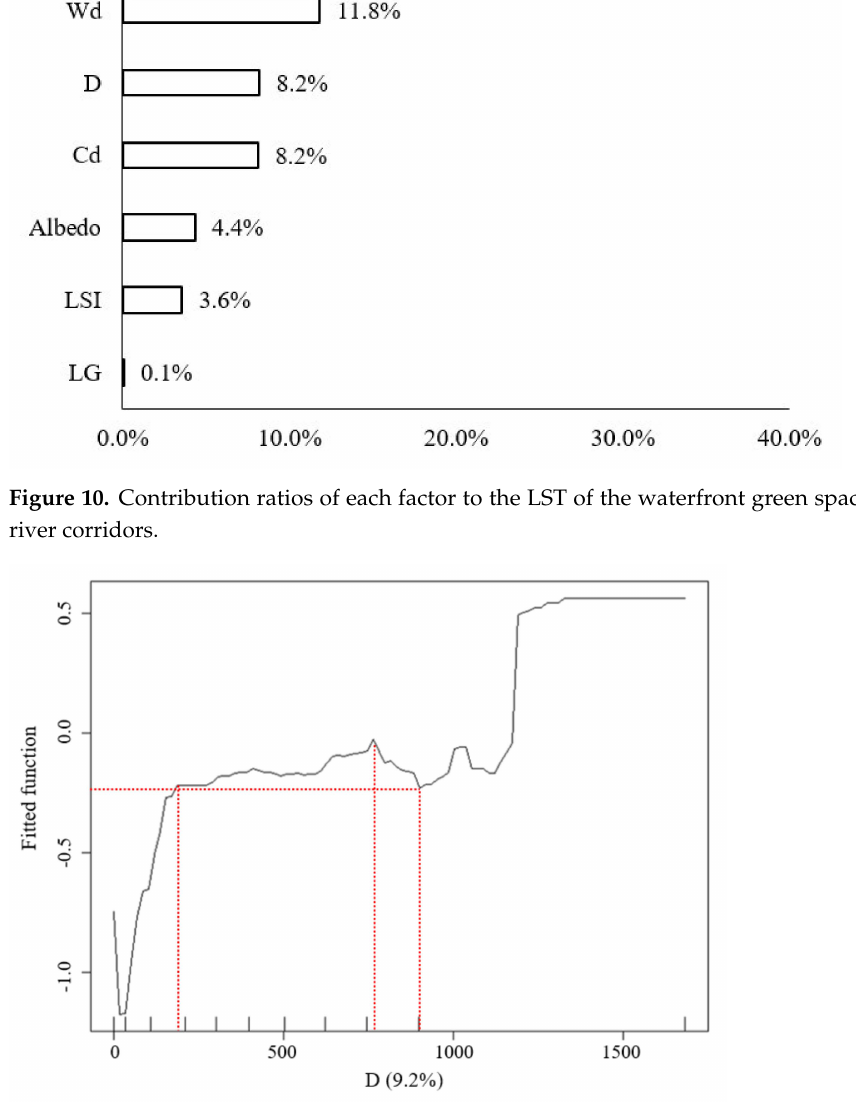
Figure 11. Relationship between the D factors and LST of the waterfront green space in the buffer zone of Width-II river